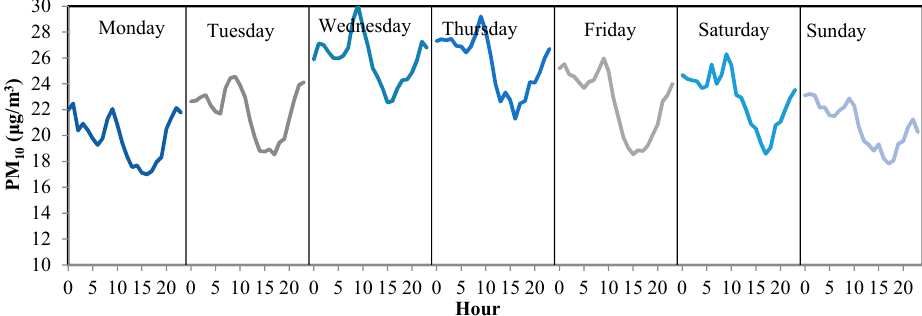
Figure 2. Weekly evolution of hourly PM 10 concentration (multiannual means). The lowest concentration values were found on Sundays (20.8 μ g/m 3 ) and Mondays (19.8 μ g/m 3 ), known as the “holiday and after holiday effect”, because of lower emissions from vehicle traffic and other sources [36]. At the beginning of the week, the daily PM 10 concentrations are starting to increase, and reach the maximum on Wednesdays 25.9 tuations over the year (Figure 3). The lowest PM 10 value was measured in June: 10.36 μ g/m 3 , when the boundary layer level is three-time higher than in winter.